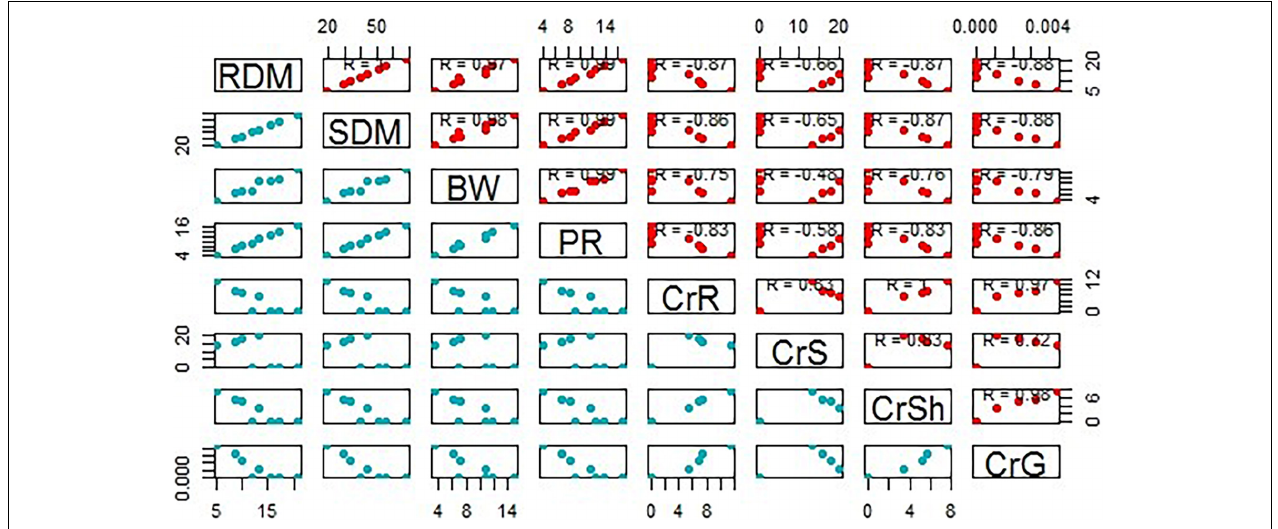
FIGURE 6 | A scatter matrix plot demonstrating pairwise scatter plots of variables in a matrix format, determining variables correlation. BW, bean weight; SDM, shoot dry mass; RDM, root dry mass; PR, photosynthetic rate; CrS, Cr in soil; CrR, Cr in the root; CRSh, Cr in the shoot; CrG, Cr in